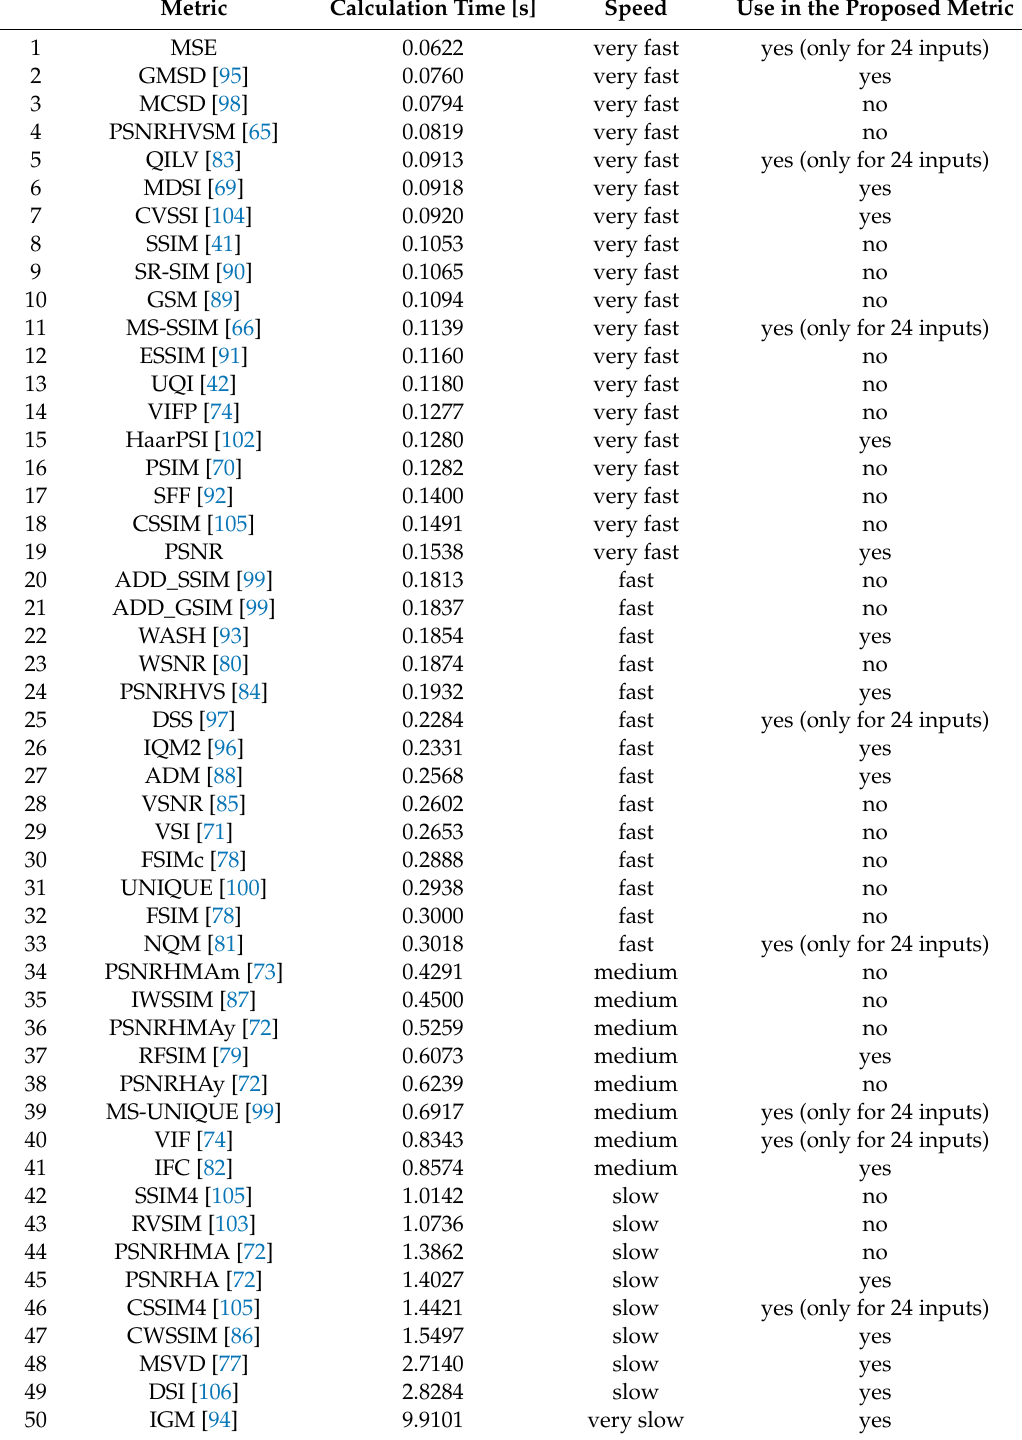
Table 7. Average calculation time for the images from the TID2013